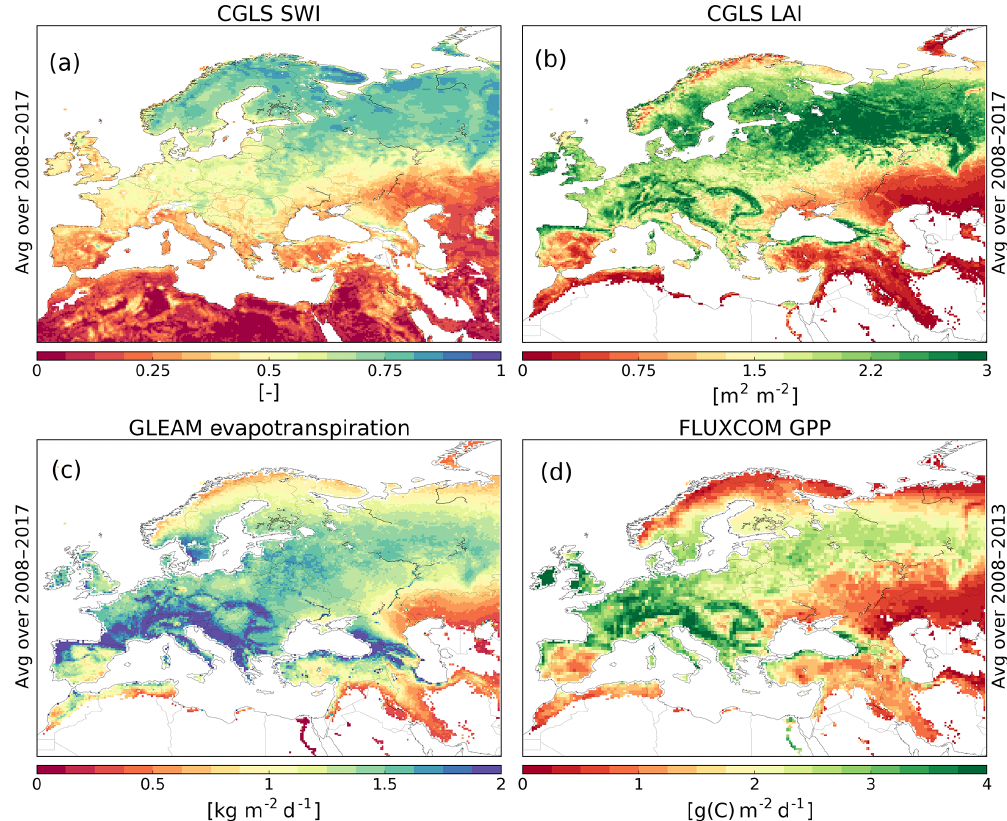
Figure 1. Satellite-derived products of the (a) original soil water index (SWI), (b) leaf area index (LAI), (c) evapotranspiration (ET) and (d) gross primary production (GPP) values. They are averaged over 2008–2017 for (a) , (b) and (c) and over 2008–2013 for (d) .